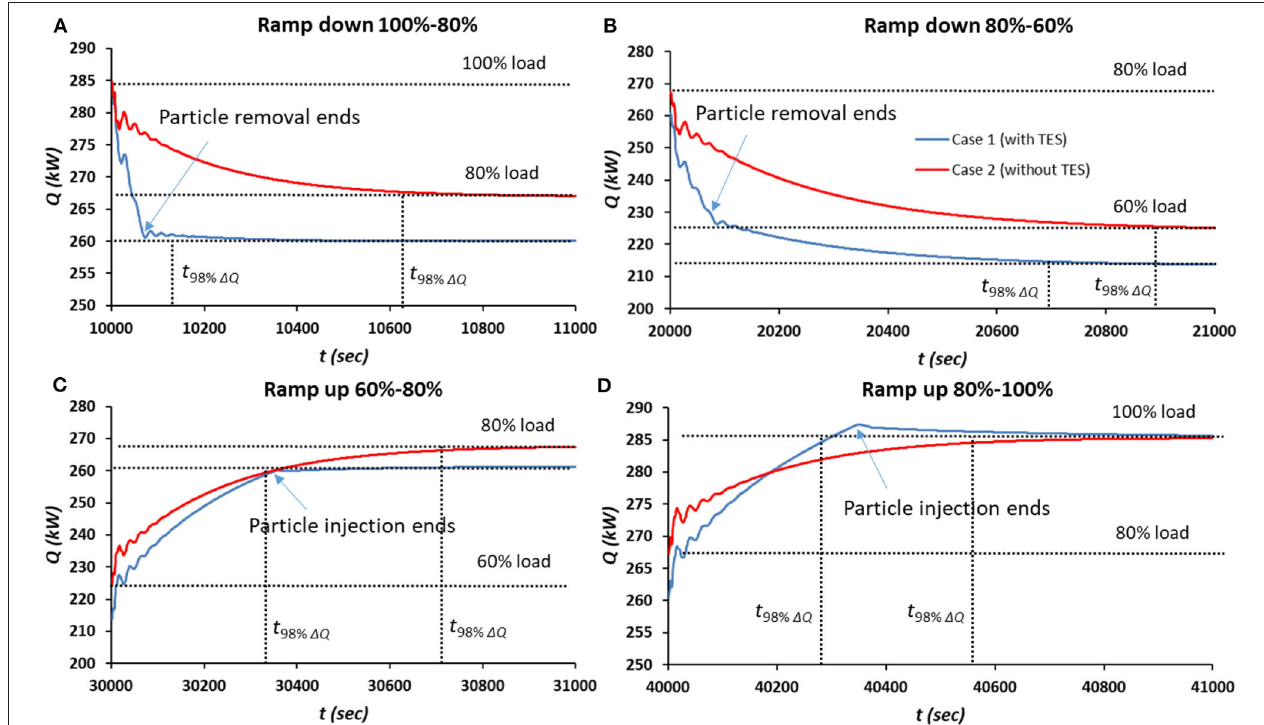
FIGURE 11 | (A-D) Zoomed regions of Figure 10B around the ramp up and down transitions (first 1,000s). The time when the particle removal/injection ends is also shown in the graphs as well as the time that the Q reaches the 98% of the 1